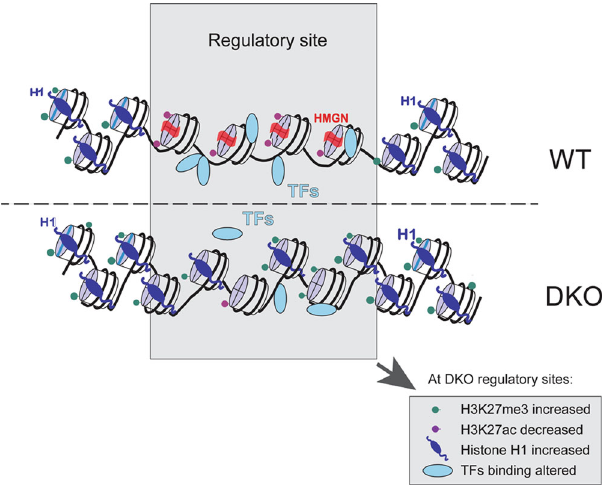
Fig. 7 Model of HMGN-mediated epigenetic changes occurring at chromatin regulatory sites. The major changes are indicated in the boxed region at the bottom of the